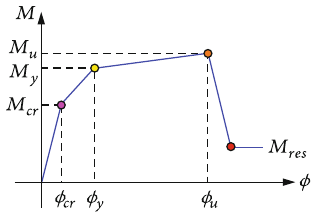
Figure 6: Moment-curvature curve to de fi ne plastic hinges on piles (not to